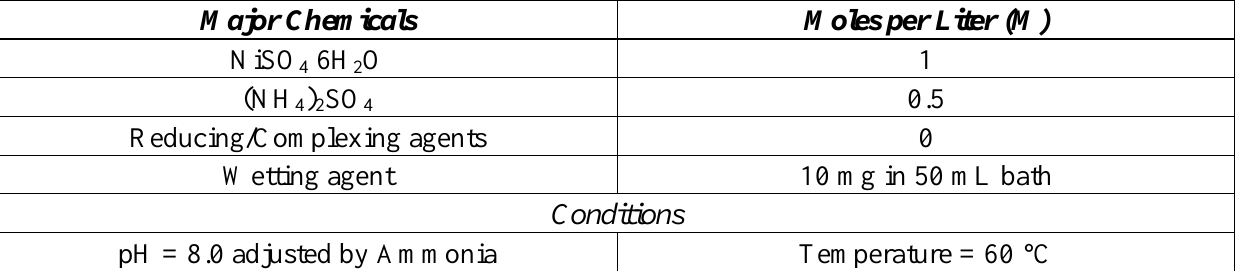
Table 1. Ni plating bath compositions and operating